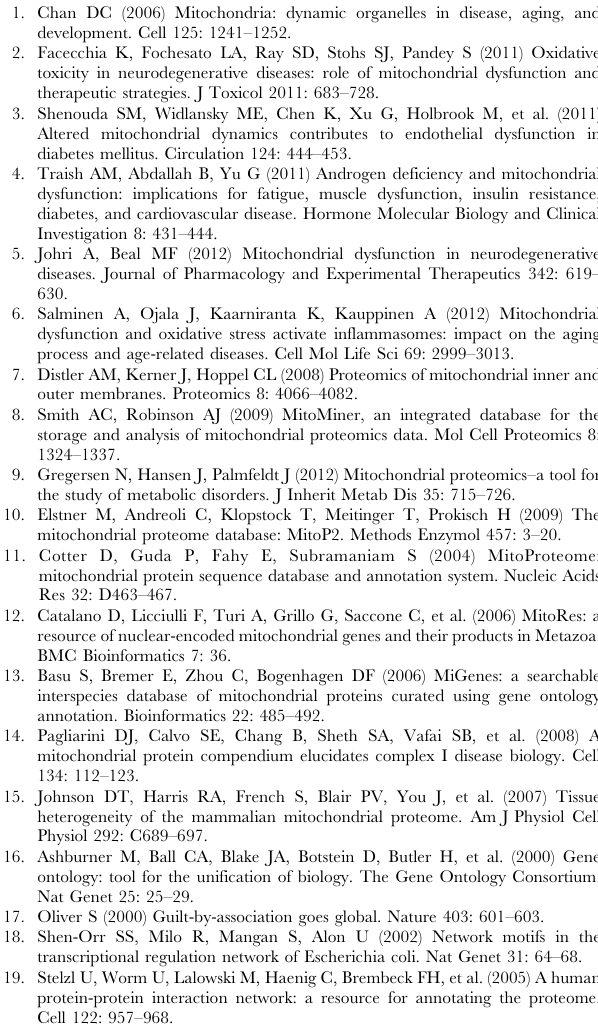
Figure S1 Measurement of the contributions of diverse datasets for constructing the FLN. (A) GO semantic similarity. (B) Four microarray experiment datasets GSE1133, (D) Protein-protein interaction (PPI), Rosetta Stone (RS), domain- domain interaction (DDI), diseases involvements (DI), genetic interaction(GI). (E) Operons. (F) Phylogenetic profiles. (G) Phenotypic semantic similarity. (H) Shared domains. Table S1 Ten-fold cross-validation results of machine-learning classifiers in Weka. Table S2 List of high-confidence mammalian mitochondrial proteins.